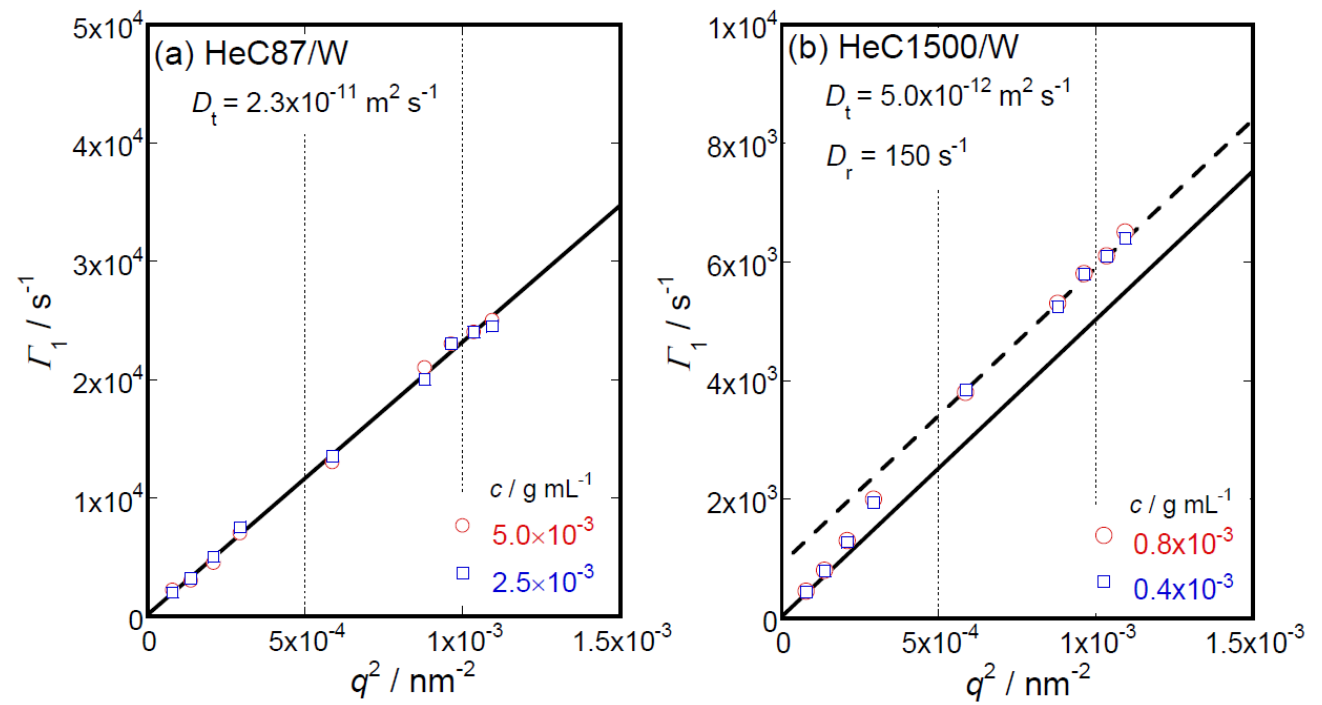
Figure 8. q 2 dependencies of the Γ 1 data for the shortest (HeC87, ( a )) and the longest (HeC1500, ( b )) samples. The broken line in ( b ) demonstrates the relationship Γ 1 = 6 D r + D t q 2 ; thus, the D r value can be evaluated from the intercept of the broken line at q 2 = 0 nm −2 .